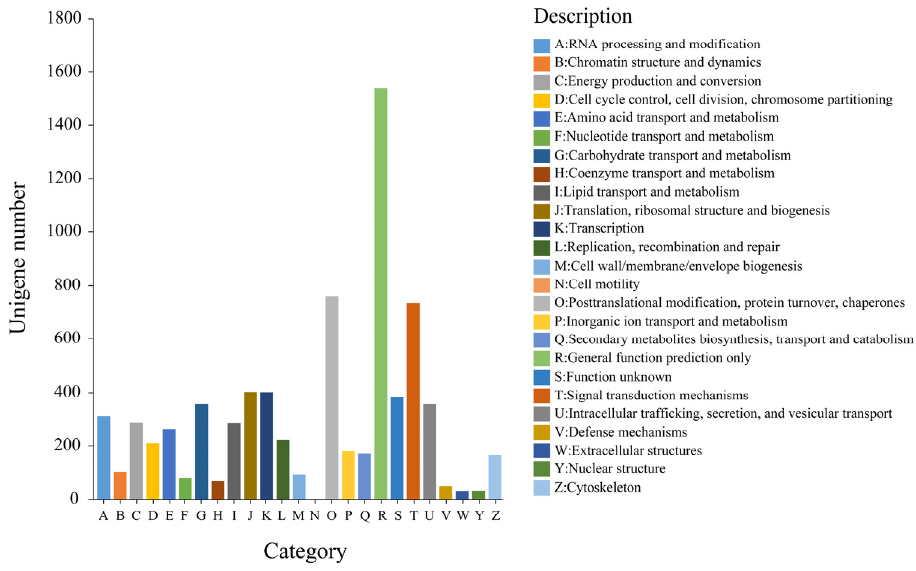
Figure 3. KOG classification of C. macrophyllum .